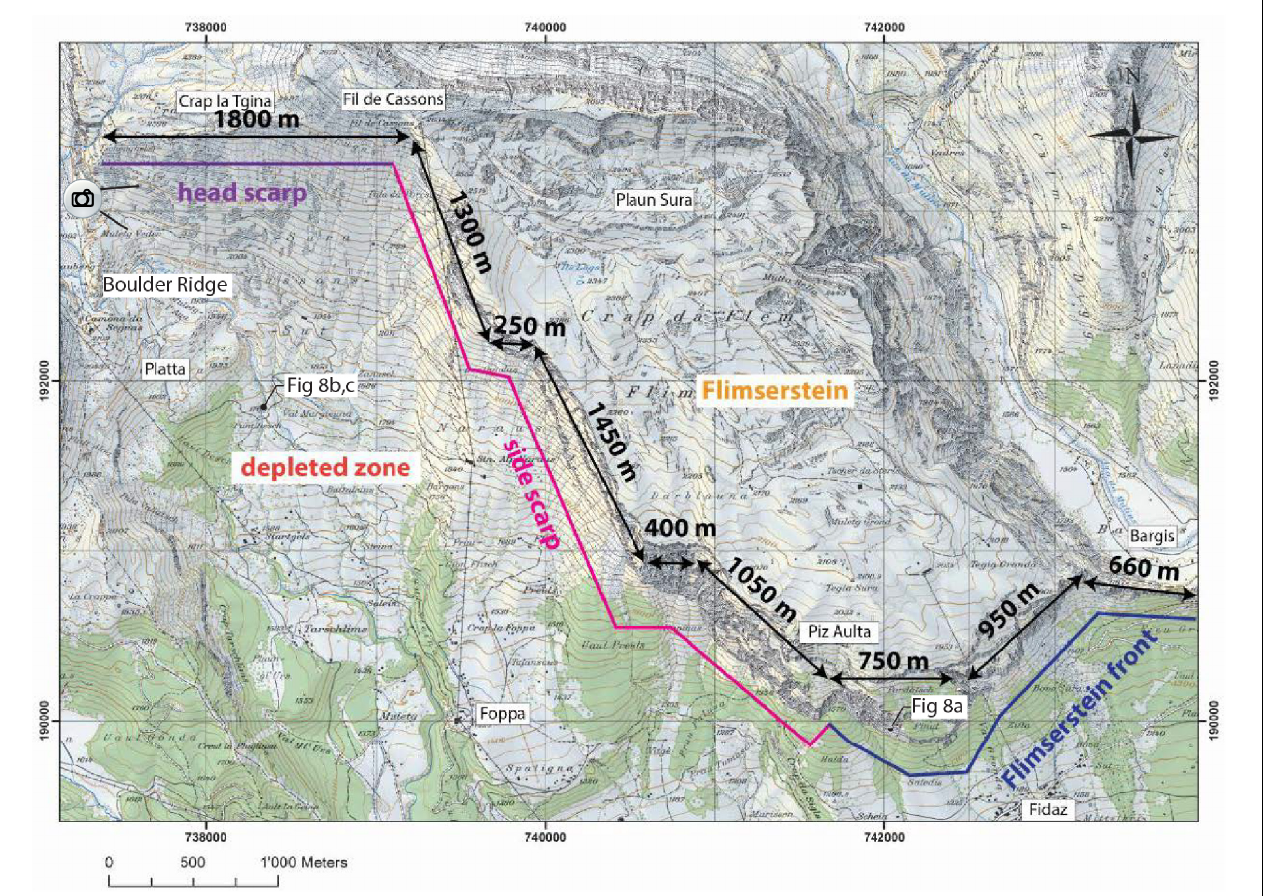
FIGURE 2 | The Flims Rockslide scarp, separated into its headscarp, lateral scarp, and the front of the Flimserstein. The location of where the image shown on Figure 3 , top was taken is shown above